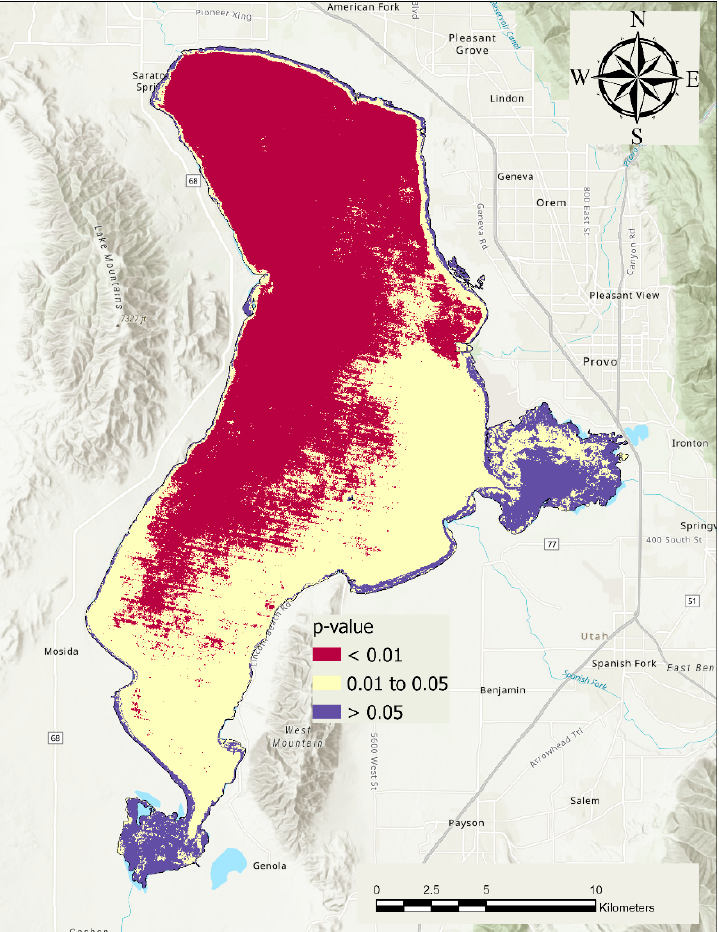
Figure 10. A map showing the distribution of p -values. Areas in maroon, yellow, and purple indicate that there is less than 1%, less than 5%, or more than 5% chance, respectively, that the computed trend is due to random processes. We selected p -value of 0.05 (5%) as the significance level.